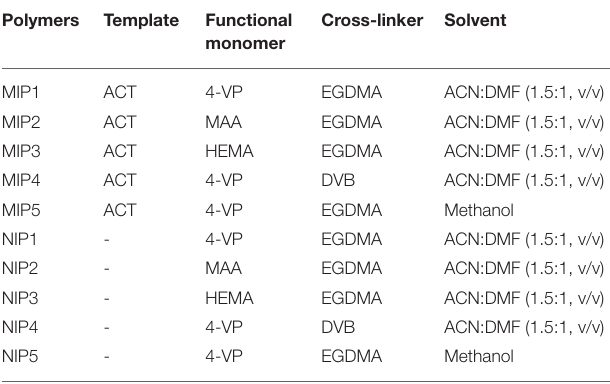
TABLE 3 | Ratio of raw materials for molecularly imprinted